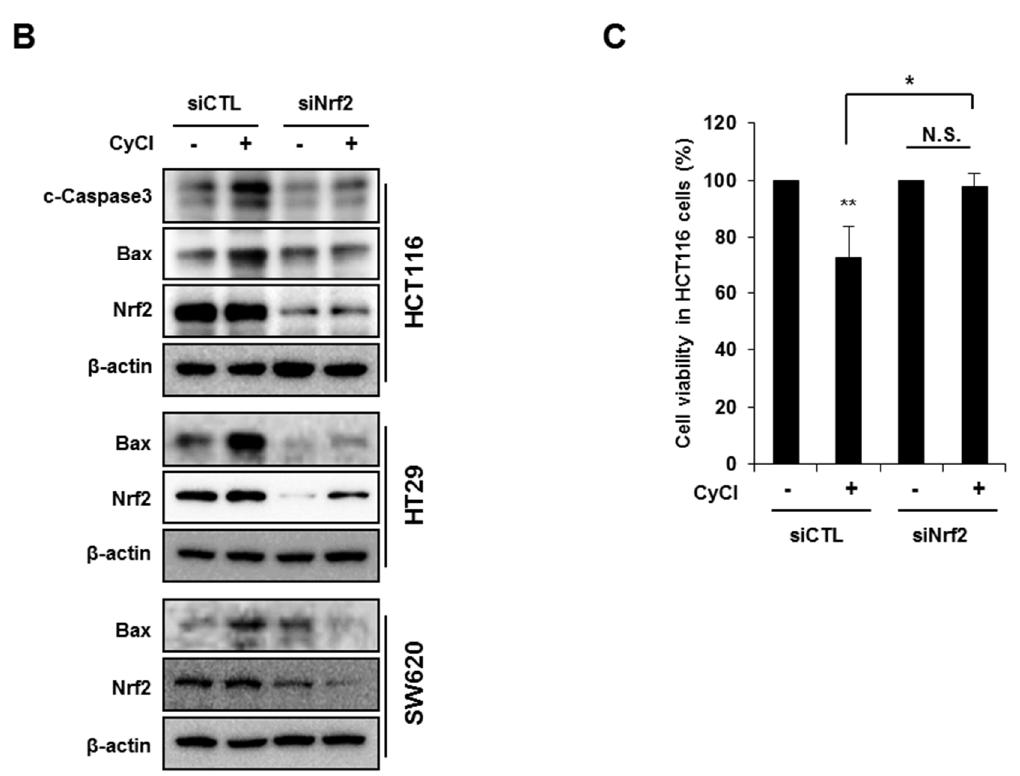
Figure 6. Knockdown of Nrf2 by Nrf2 small interfering RNA (siRNA) abolishes CyCl-induced apoptosis. ( A ) HCT116, HT29, and SW620 cells were transfected with 15 nM of control or Nrf2 siRNA. After 24 h, cells were treated with 50 µM of CyCl for 24 h and harvested. The expression of Nrf2, Bax, and Bcl2 mRNA was measured by qRT-PCR. ( B ) HCT116, HT29, and SW620 cells were transfected with 15 nM of control or Nrf2 siRNA for 24 h and treated with 50 µM of CyCl for 24 h. After protein isolation, Western blot analysis was conducted for the levels of cleaved caspase-3, Bax, and Nrf2 protein. ( C ) HCT116 cells were transfected with control or Nrf2 siRNA for 24 h and treated with 50 µM of CyCl for 24 h. Cell viability was evaluated by 3-(4,5-dimethylthiazol-2-yl)-2,5-diphenyltetrazolium bromide (MTT) assay. All experiments were carried out in triplicate. * p < 0.05, ** p < 0.01, and *** p < 0.001, significantly different compared with empty vector-transfected control; # p < 0.05 and ### p < 0.001, significantly different compared with siNrf2-transfected control.